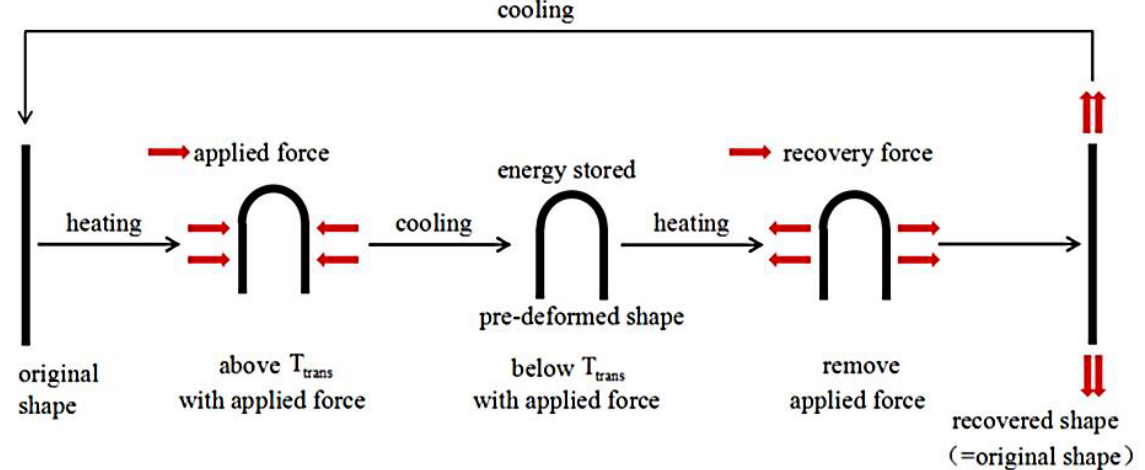
Figure 9. Schematic of thermal deformation shape memory epoxy material [119]. Reproduced with permission from MDPI.